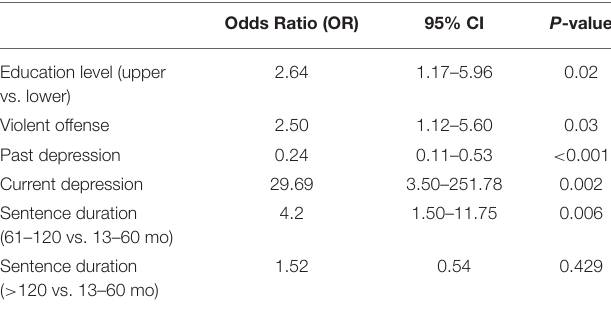
TABLE 4 | Multivariable regression identifying factors associated with the natural remission from PTSD among incarcerated women. Odds Ratio (OR) 95% CI P